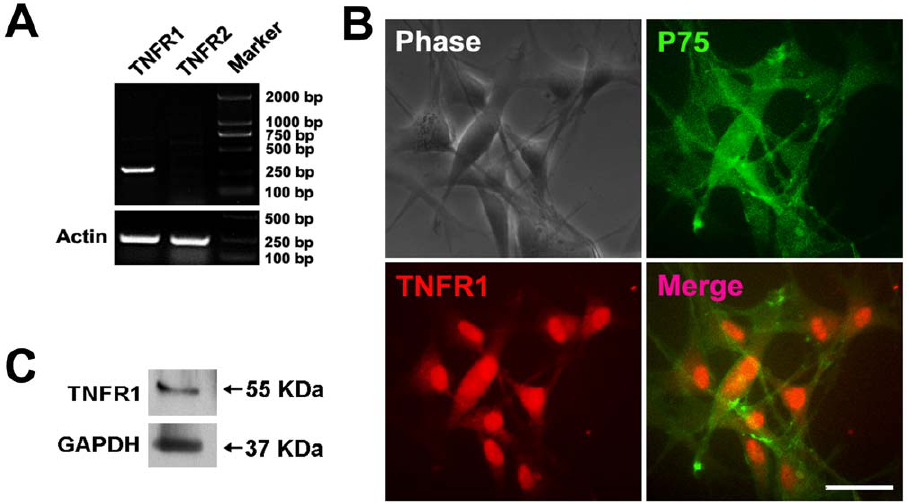
Figure 3. TNFR1 is expressed on OECs. (A) The mRNA of TNFR1 (301 bp) but not TNFR2 (264 bp) was identified in OECs by RT-PCR. (B) Cultured OECs were double-stained with antibodies against P75 and TNFR1 after treatment with Triton X-100. Scale bar=50 m m. (C) Western blotting analysis for the expression of TNFR1 cell lysates of cultured OECs. GAPDH blotting severed as the loading control.